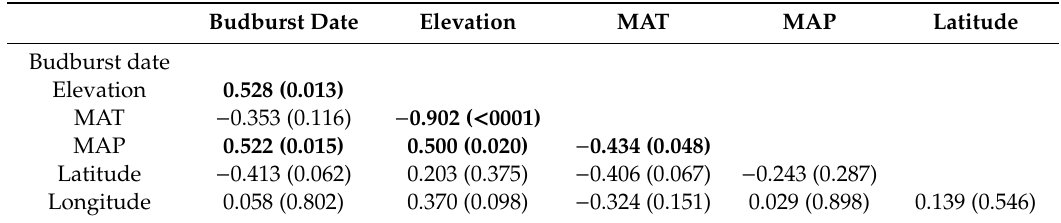
Table 2. Correlation coe ffi cients between provenance environmental characteristics and budburst date ( n = 21). Values in parentheses are p values. Boldface type indicates significance ( p <